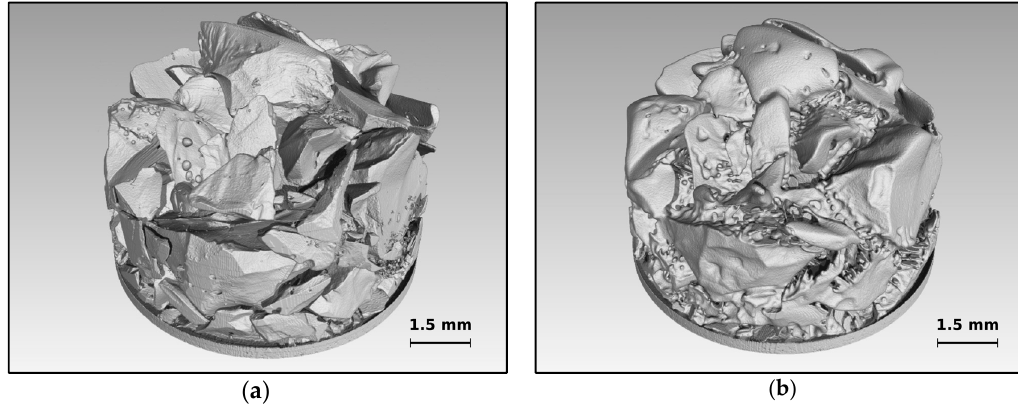
Figure 2. 3D snapshots of ice samples obtained from µCT scans in a long-term experiment over a period of 196 h. The course of the experiment is described in the text. ( a ) Initial state of the ice after loading the sample and performing scan S1; ( b ) Final state of the ice before melting (scan S9). Although big parts of the sample sintered together the initial structure is still visible.